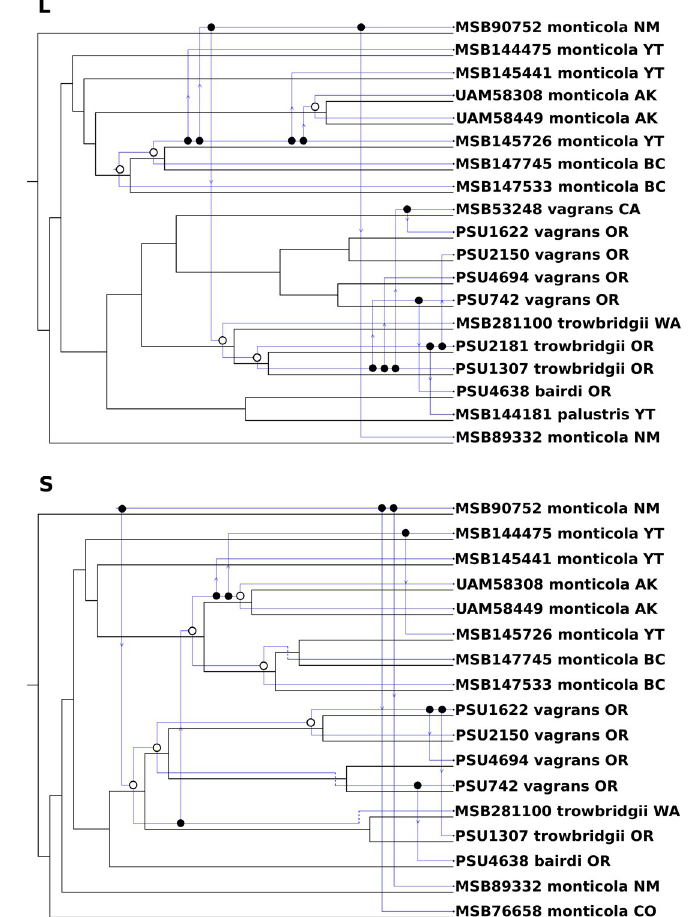
Figure 4. Phylogenetic reconciliation for the Jemez Springs virus L and S in blue and the Sorex vagrans complex phylogeny in black. Open circles represent codivergence events, solid circles followed by an arrow indicating host-switching events and direction, and dashed lines represent virus extinction events. State abbreviations are as shown in Figure 1.